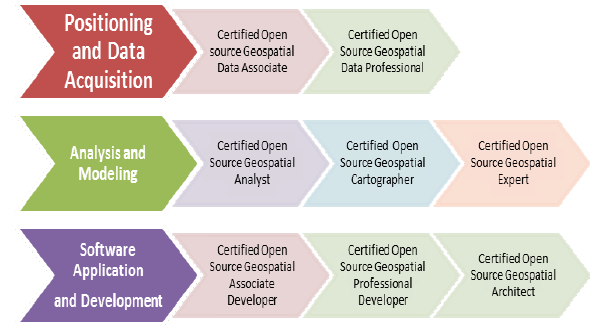
Figure 3: Developed Certification Packages